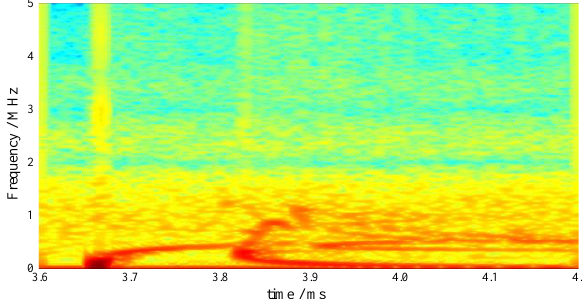
Figure 10. Time-frequency joint spectrum of the free surface velocity of bar 01.